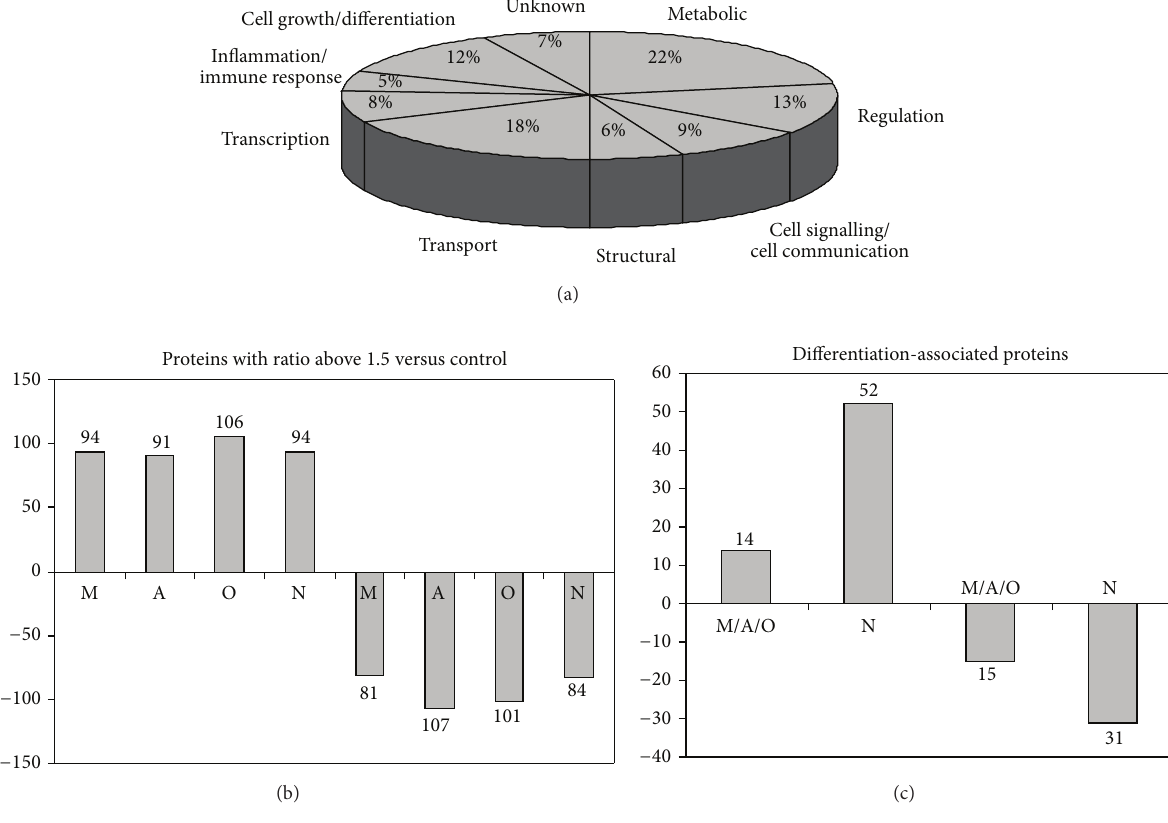
Figure 4: Differentially expressed proteins in AF-MSCs of second-trimester undergoing myogenic (M), adipogenic (A), osteogenic (O), and neurogenic (N) differentiation. (a) Venn diagram depicting functional classification of differentiating cell proteins expressed 1.5-fold above control. (b) Number of up- and downregulated proteins and (c) differentiation-associated proteins with ratio 1.5 versus control in each differentiating